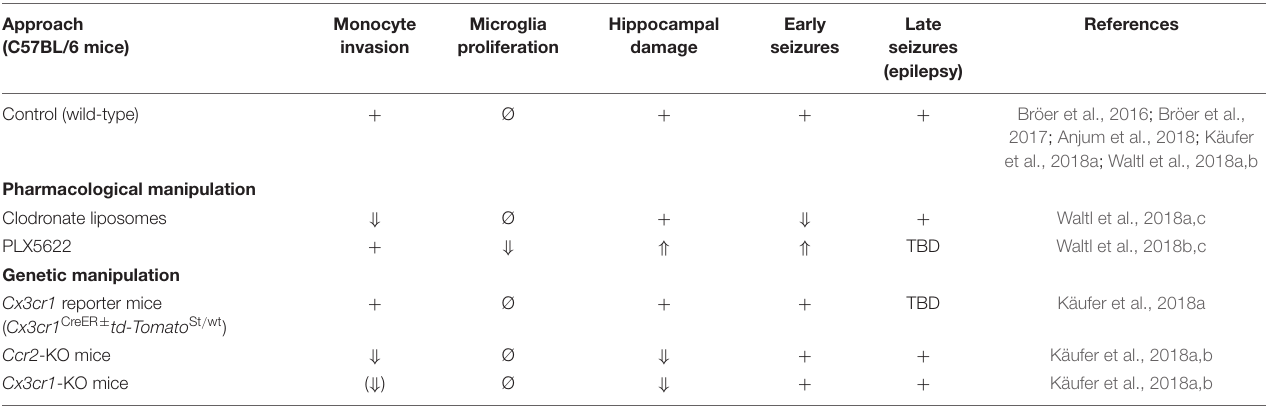
Data are from TMEV-infected C57BL/6 mice, using the DA strain of TMEV for intracerebral inoculation. In addition to data from flow cytometry shown in the table for monocyte invasion and microglia proliferation, neuroinflammation was also assessed by immunohistochemistry (Iba1, Mac-3, CD3), T cell and neutrophil infiltration, and qPCR (cytokines). A significant increase in infected wild-type controls or Cx3cr1 reporter mice compared to sham-infected controls is indicated by “+” and lack of such alteration by “Ø”. A significant decrease or increase by pharmacological or genetic manipulation compared to infected wild-type controls is indicated by arrows. TBD, to be